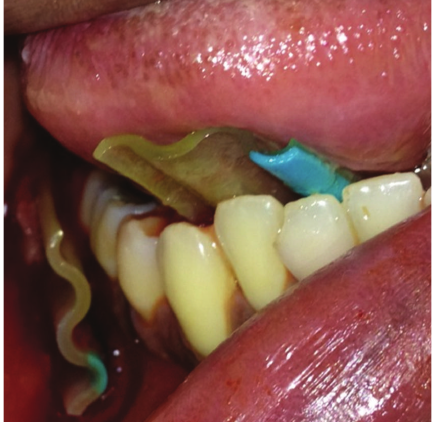
Figure 4: Closeup view of intraoral drains.